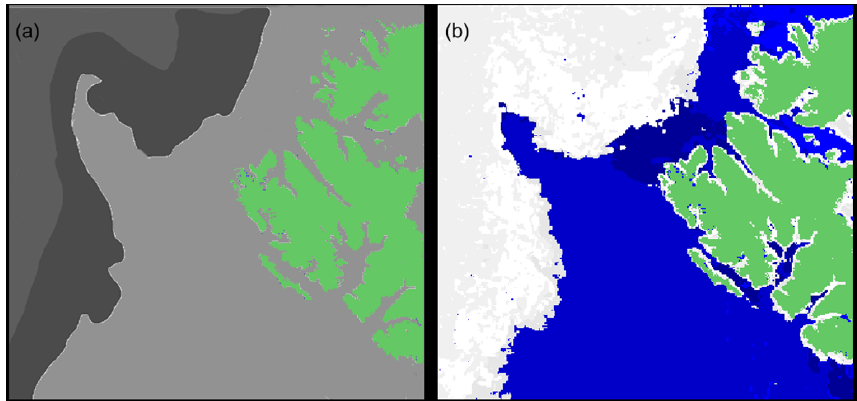
Figure 6. OW and sea ice classification of RS2 SCW image shown in Fig. 2. (a) Manual classification based on sea ice expert analysis to delineate sea ice (in the MIZ and general sea ice cover) and open water (calm and rough open water): dark gray is sea ice; very dark gray is marginal ice zone; light gray is OW; green is land. (b) Automatic SVM classification result: white is sea ice; dark blue is calm OW; blue is OW; green is